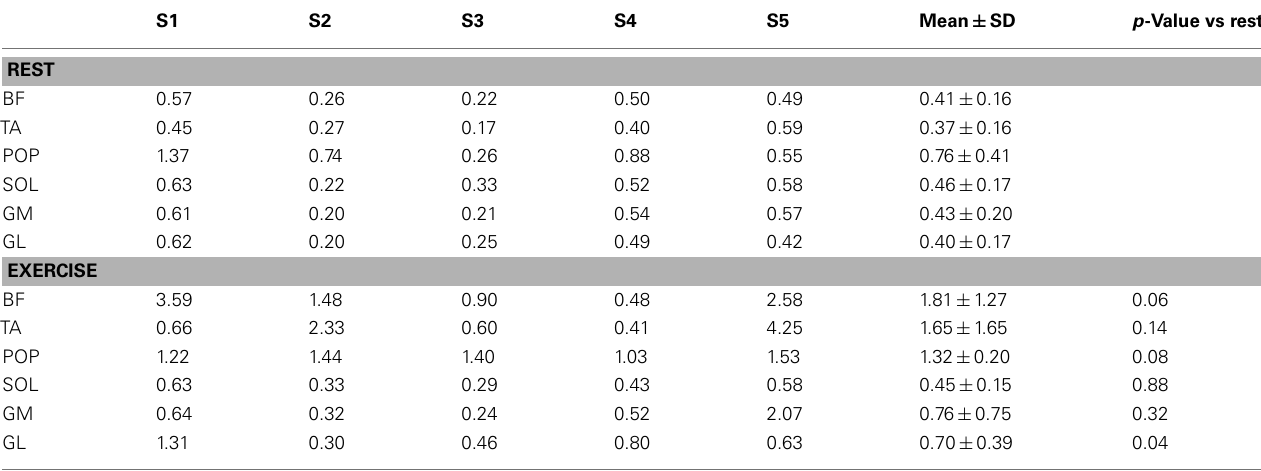
Table 1 | Muscle glucose uptake index at rest and during exercise in other selected thigh and leg muscles in five study subjects (S1–S5) and the mean ± SD of the subjects. S1 S2 S3 S4 S5 Mean ± SD p -Value vs